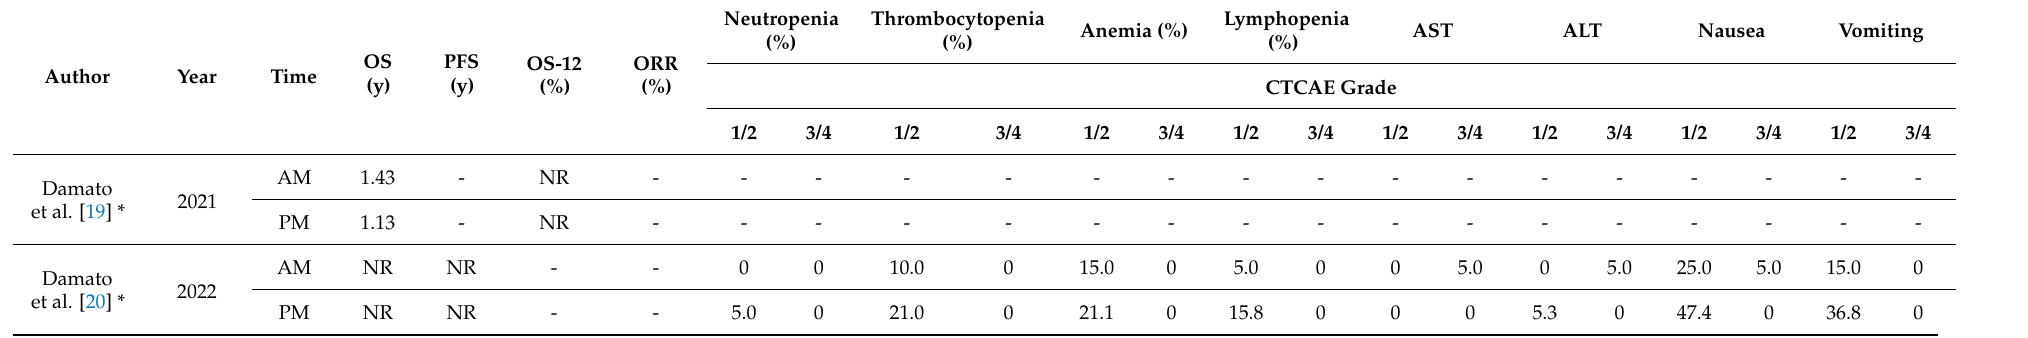
(OS: overall survival; PFS: progression-free survival; OS-12: overall survival at 12 months; ORR: objective response rate; AST: aspartate transaminase elevation; ALT: alanine transaminase elevation). * Campian et al. [21] and Atluri et al. [22] report the pre-publication results of this completed study. ** PJP incidence, hospitalization rate, and discontinuation rate were not described in either